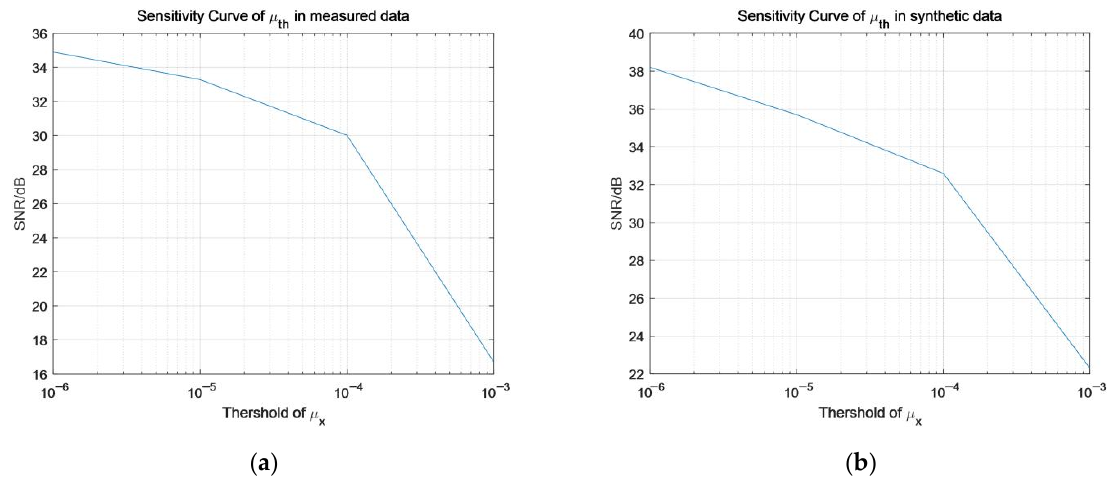
μ in different data. ( a ) Sensitivity curve of Figure 2. Sensitivity curve of Figure 2. Sensitivity curve of µ th in different data. ( a ) Sensitivity curve of µ th in measured data. th μ in synthetic data ( b ) Sensitivity curve of ( b ) Sensitivity curve of µ th in synthetic th